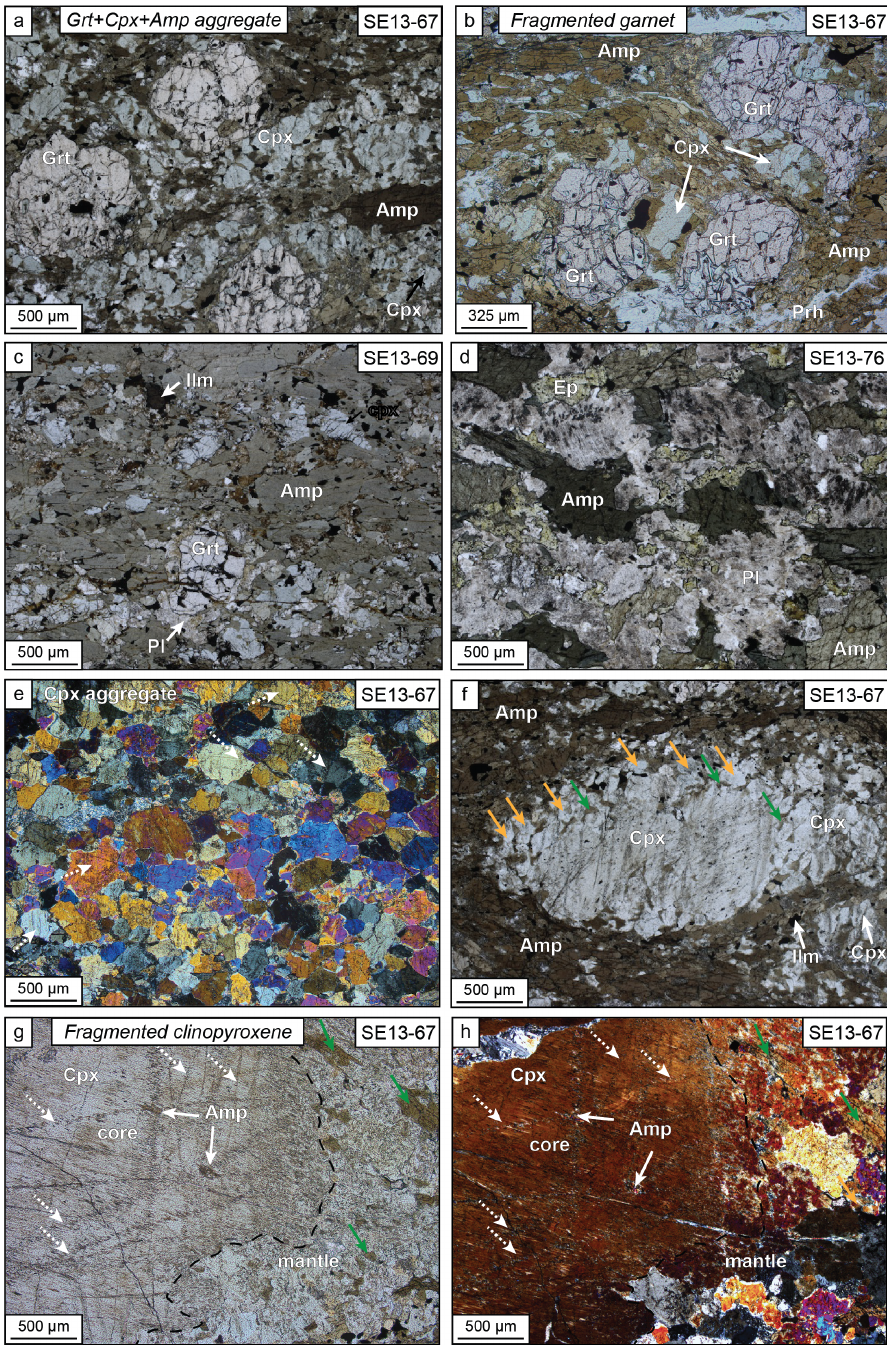
Figure 5. Photographs of representative microstructures in the HTa amphibolites. (a) Garnet porphyroclasts surrounded by a fine-grained matrix of Cpx + Amp (Area 3); (b) fractured garnet porphyroclast with fractures filled by a fine-grained matrix composed of Cpx + Amp; (c) ∼ 8m from the contact, showing greater retrogression characterized by an increase in plagioclase and brown amphibole at the expense of Grt + Cpx; (d) ∼ 25m from the contact (base of HTa), highly retrogressed amphibolite associated with secondary crystallization of coarse- grained brown-to-green amphibole, epidote and plagioclase; (e) monomineralic layer of recrystallized clinopyroxene by subgrain rotation; (f) sheared Cpx porphyroclast wrapped by fine-grained brown Amp (Area 2); (g) and ( h ; cross polarized light) core-and-mantle structure in a Cpx porphyroclast with and minute amphibole in sealed microfractures (fluid inclusions trails) and at grain boundaries of the porphyroclast mantle. Orange and green arrows point to small new clinopyroxene deriving from the fragmented clinopyroxene porphyroclast and secondary amphibole, respectively. See details in the